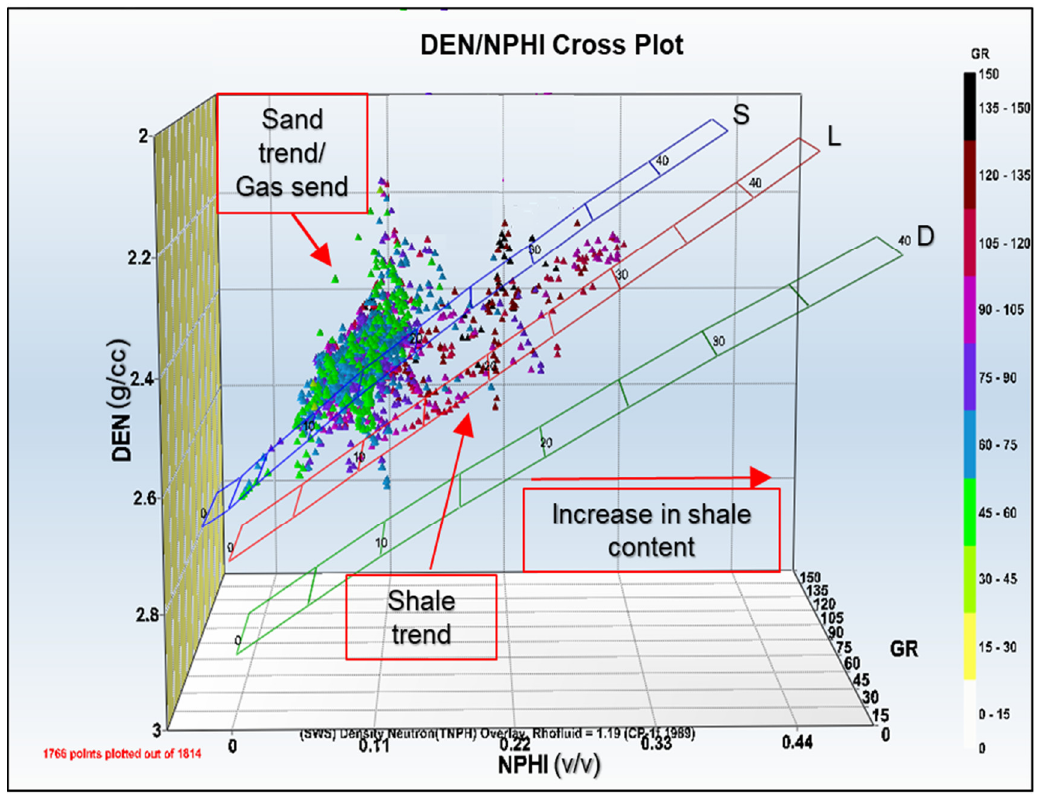
Figure 6. Density (RHOB)/neutron (NPHI) cross plot for multi-well analysis with discriminator gamma-ray response.